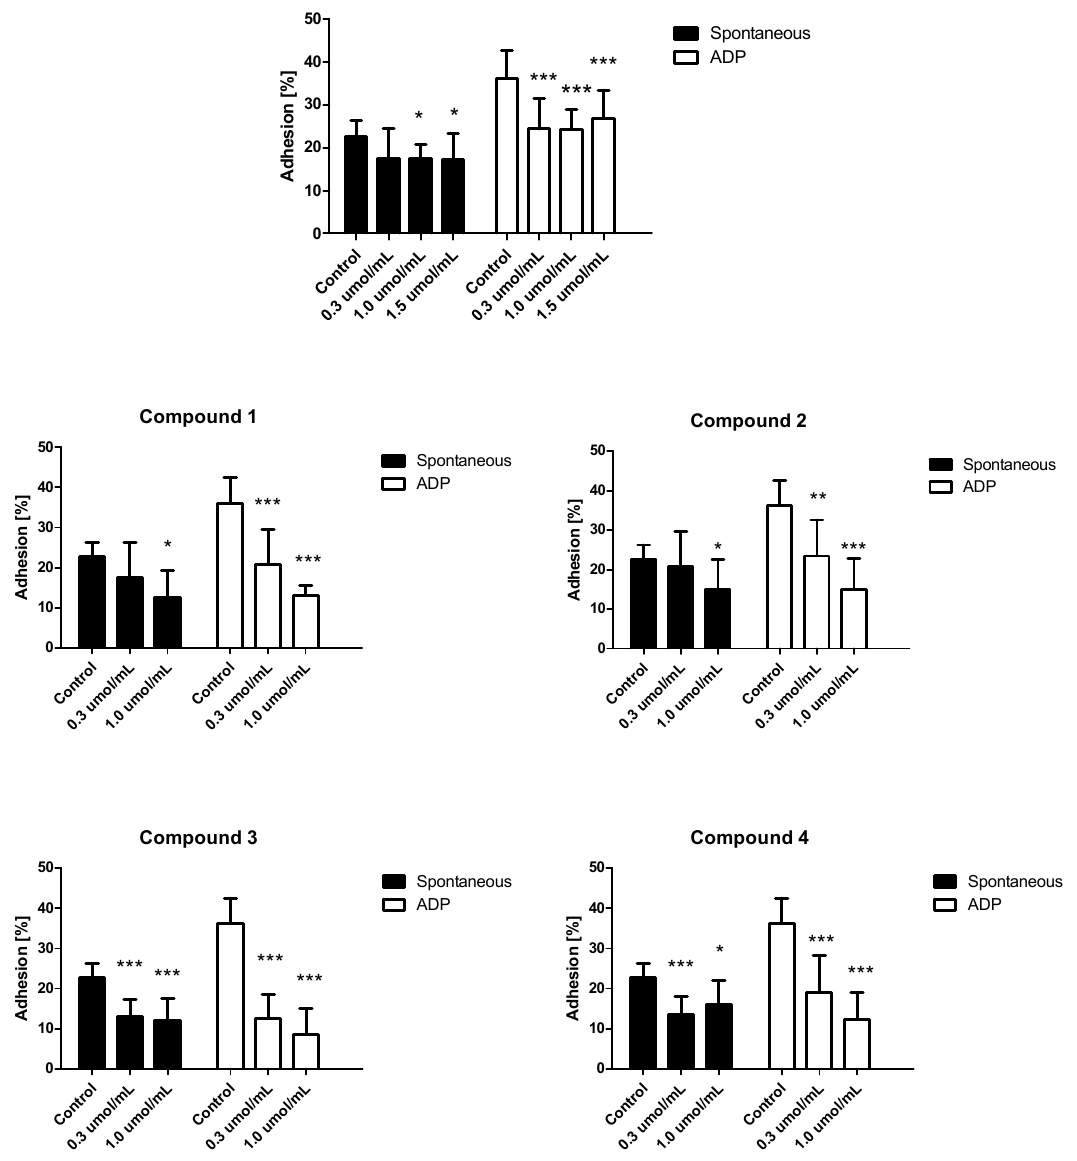
Figure 7. In vitro e ff ect of metformin and its derivatives ( 1 – 4 ) on spontaneous and ADP-induced platelet adhesion (%). The results are presented as mean ± SD, n = 9–12. * p < 0.05; ** p < 0.01; *** p < 0.001. Two-way Anova analysis did not reveal any significant di ff erences between the tested compounds with regard to their e ff ects on spontaneous or ADP-induced platelet adhesion.